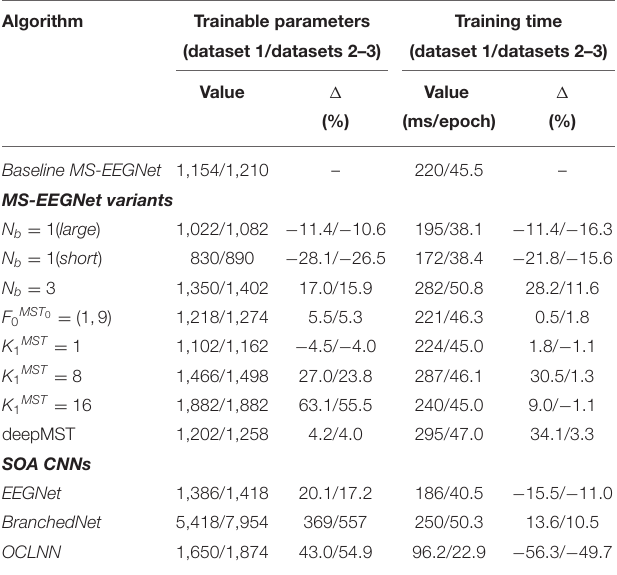
TABLE 2 | Number of trainable parameters, also denoted as model size in the text, and training time (referred to the WS strategy), also denoted as computational time, of the baseline MS-EEGNet, MS-EEGNet variants, and SOA CNNs when using signals from dataset 1 and datasets